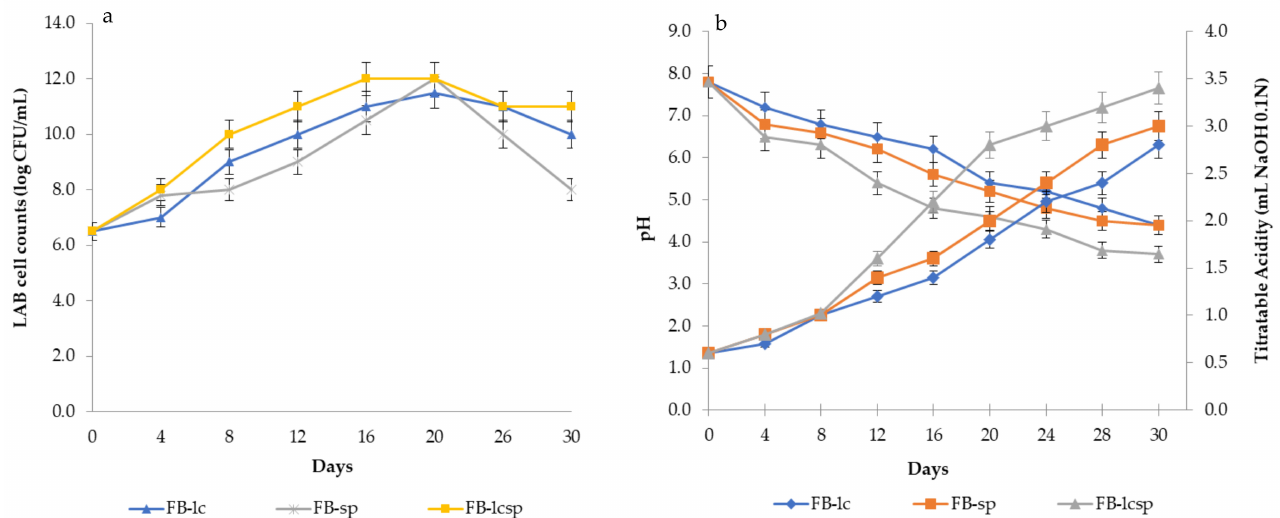
Figure 1. LAB cells count, expressed as log of colony forming unit/mL ( a ), pH and titratable acidity ( b ) of the three different products during the lactic acid fermentation process. Results are reported as mean values of 3 replicates.